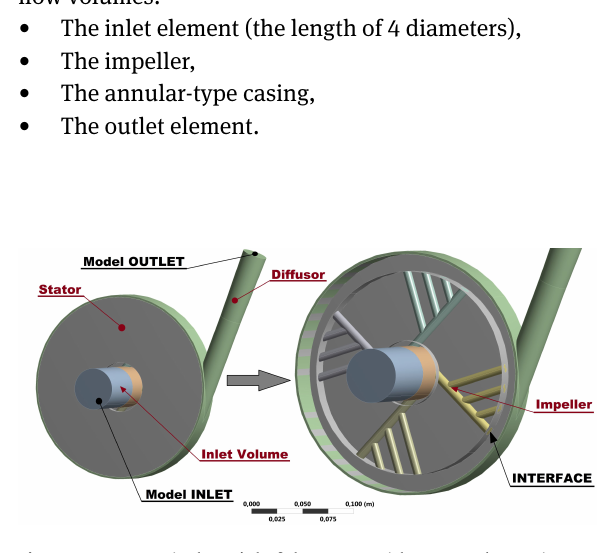
Figure 5: Geometrical model of the pump with an annular casing